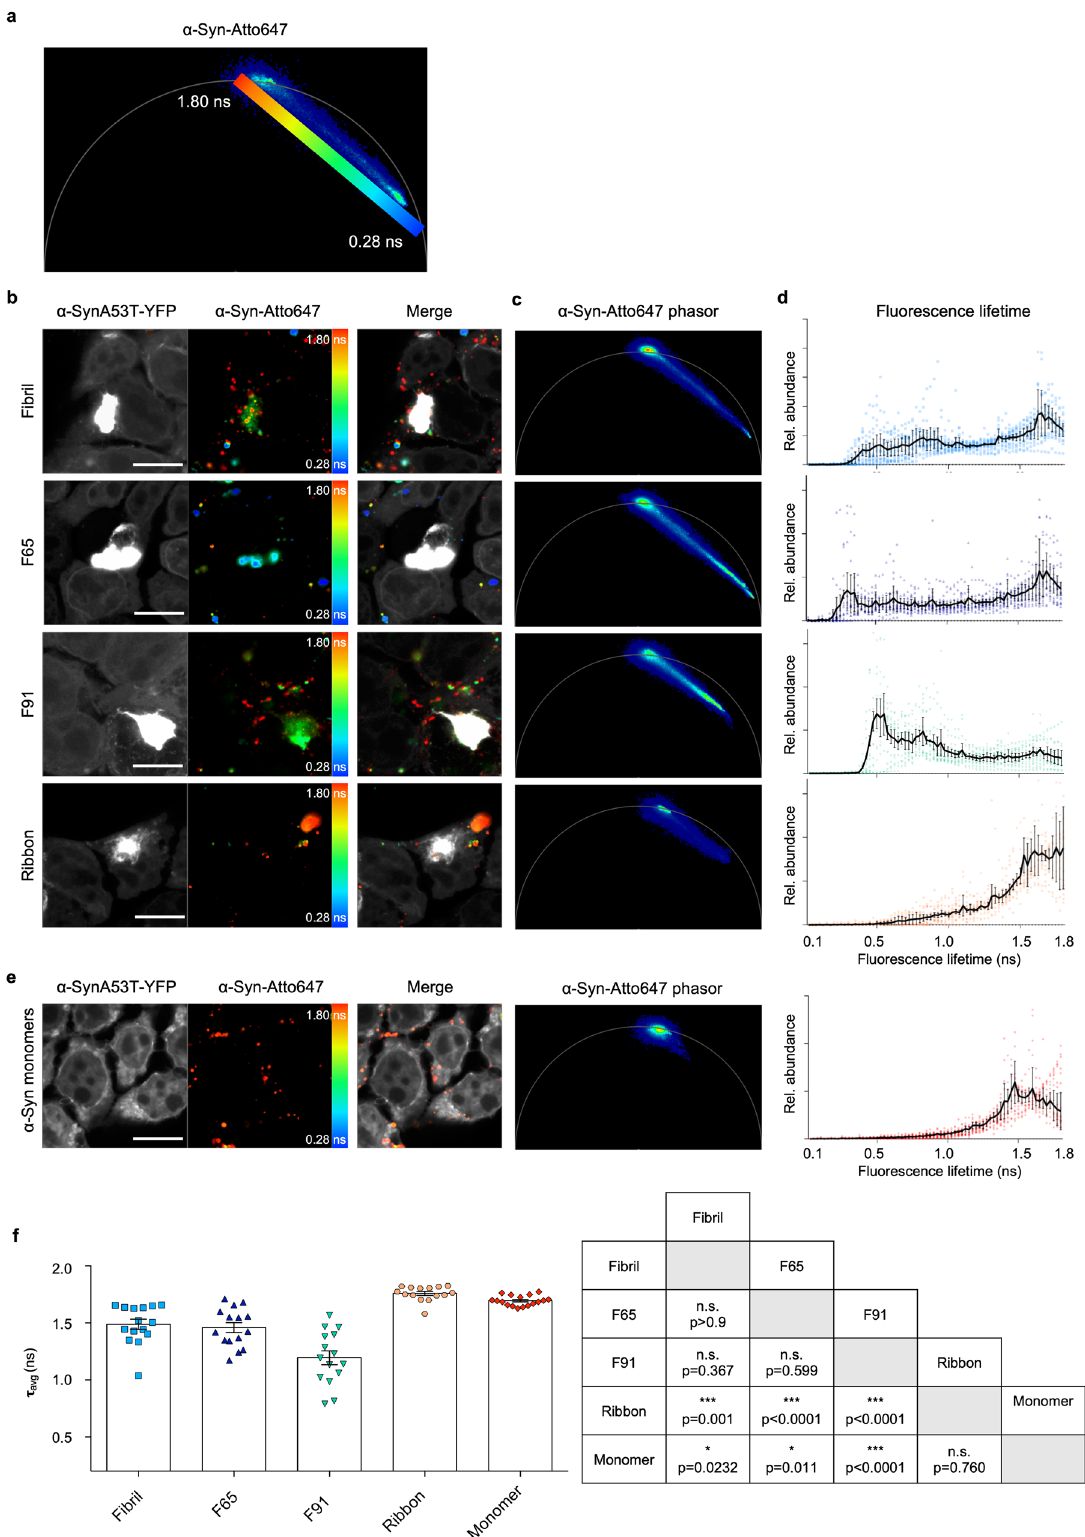
species with the shortest fl uorescence lifetime that do not appear with Fibrils and F91, while F91 formed species with a fl uorescence lifetime of no less than 0.5 ns. Conversely, Ribbons did not exhibit such a wide distribution of fl uorescence lifetimes, with the majority of seeds exhibiting a mean lifetime of 1.7 ns, which was similar to the mean lifetime of monomeric α -Syn in the cellular